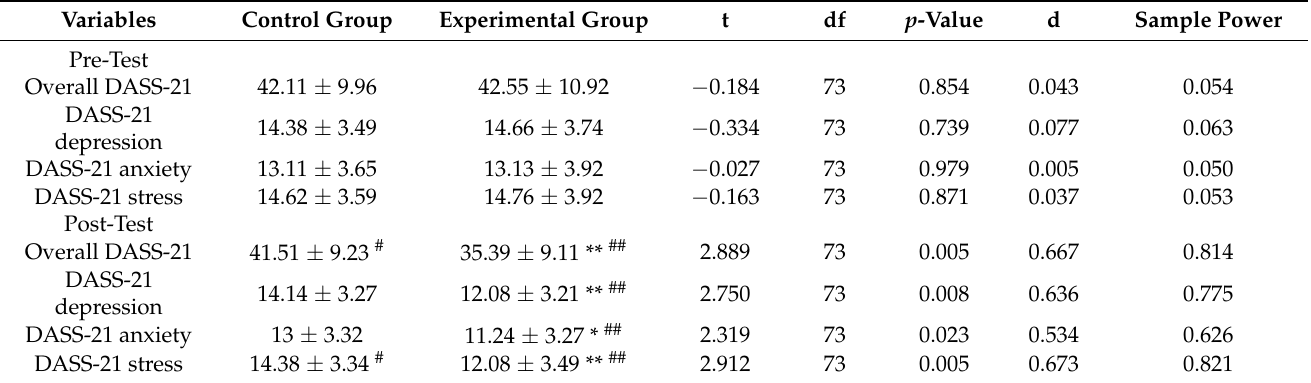
Table 4. Comparison of DASS-21 across two intervals between two groups.